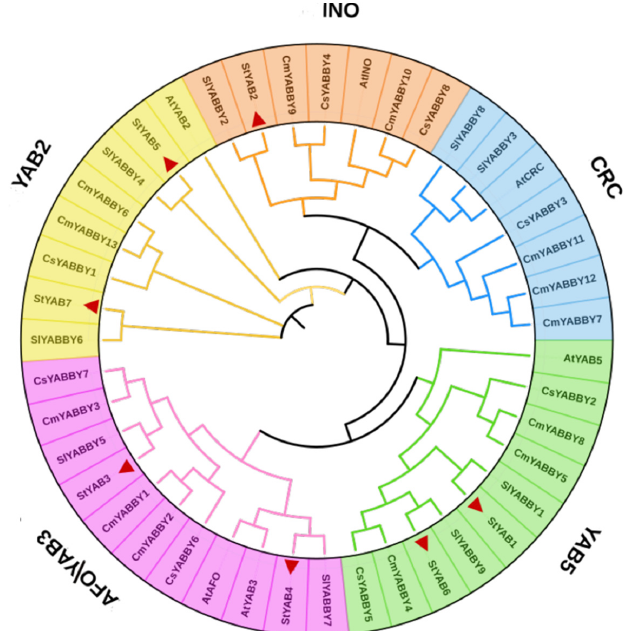
Figure 3. Phylogenetic relationship among the YABBY genes of S. tuberosum , A. thaliana , S. lycopersicum , C. sativus , and C. maxima was studied. S. tuberosum genes are marked with a red triangle. The evolutionary history was inferred using the NJ method with 1000 bootstrap replications. This analysis involved 43 YABBY genes. The evolutionary analyses were conducted in MEGA 11.